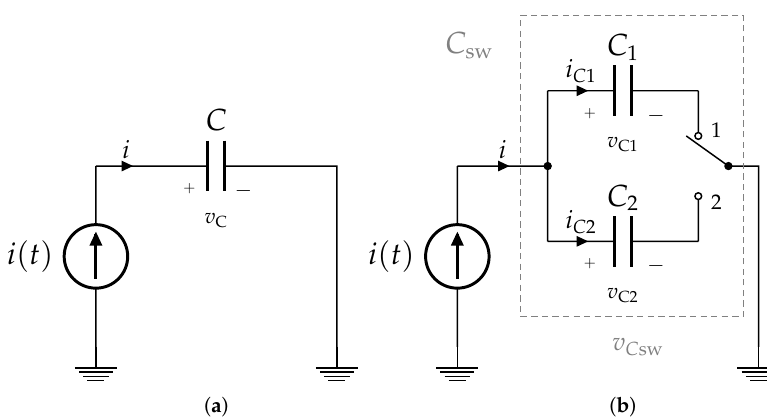
Figure 4. A capacitor connected to a current source: ( a ) single capacitor; and ( b ) switched capacitor